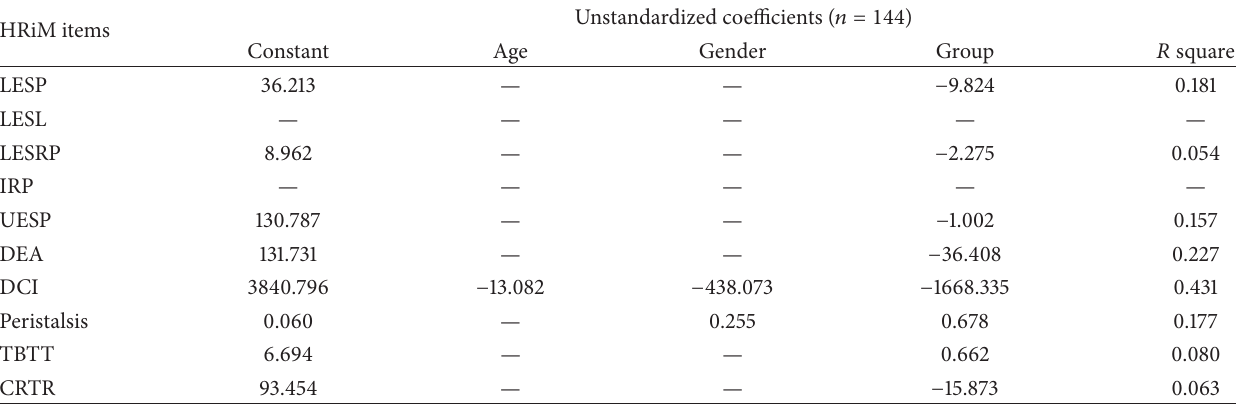
Table 4: Results of stepwise linear regression analysis of different demographic data on items of HRiM in Chinese healthy volunteers and GERD